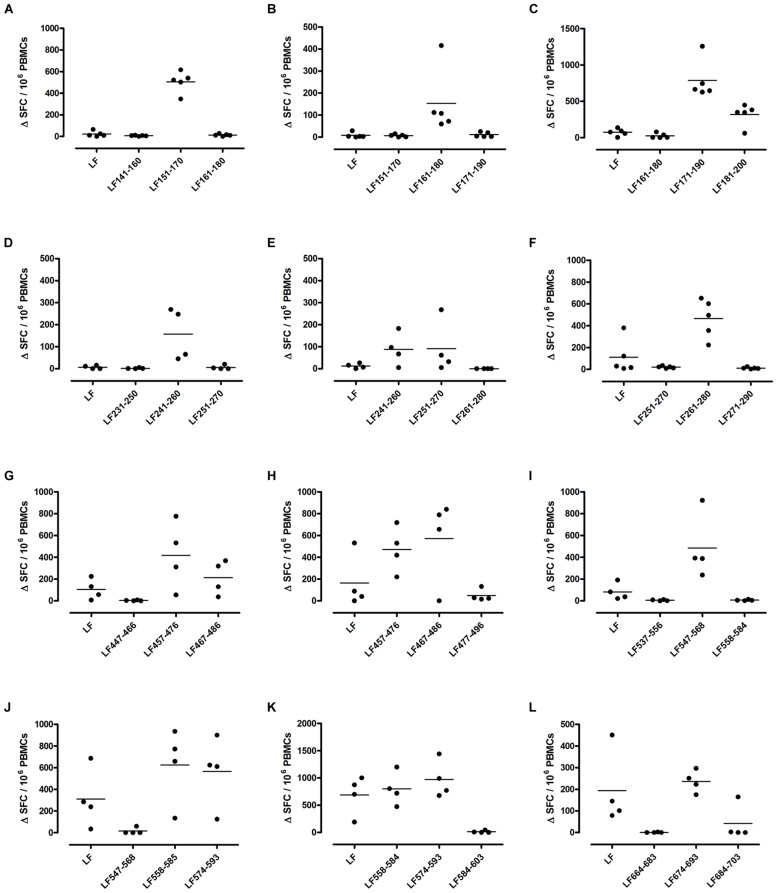
Immunodominant HLA-DR1 restricted T cell epitopes. HLA-DR1 transgenics were immunized with each of the immunodominant peptides separately (A–L), and draining lymph node cells were cultured in an IFNγ specific ELISpot plate with the immunizing and flanking peptides or LF protein for 72 h. Results are given as the number of spots above background (ΔSFC)/106 PBMCs with mean ± SD (n = 4–5 mice for each column).